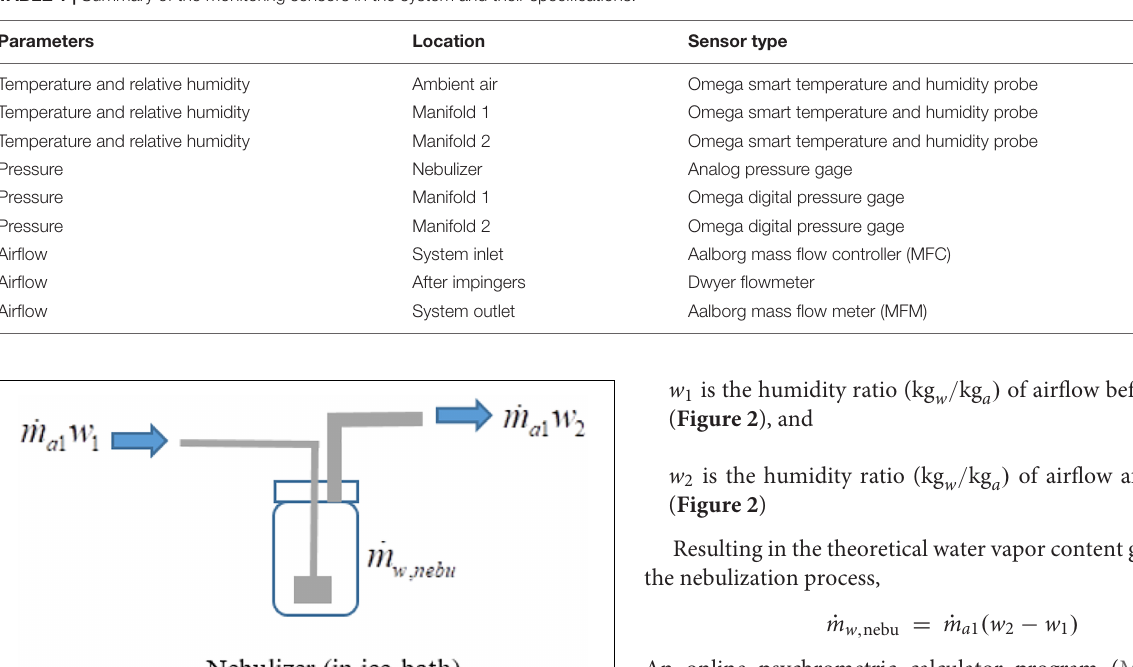
TABLE 1 | Summary of the monitoring sensors in the system and their specifications.